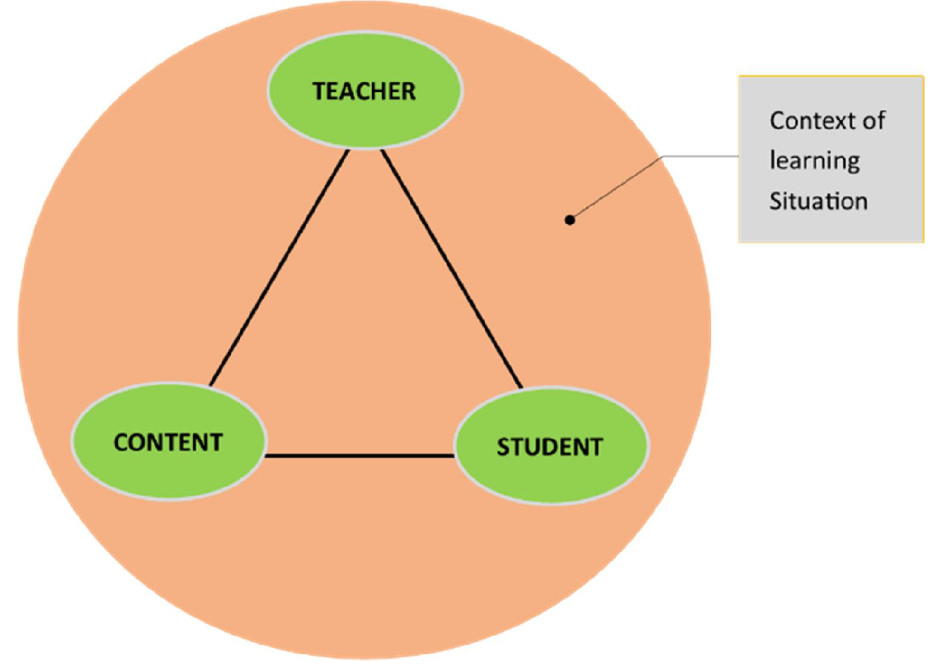
Figure 1. Didactic